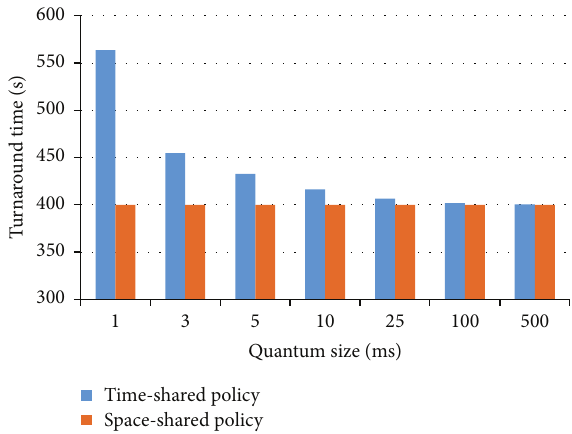
Figure 4: Indirect context switch cost and the size of quantum parameter.